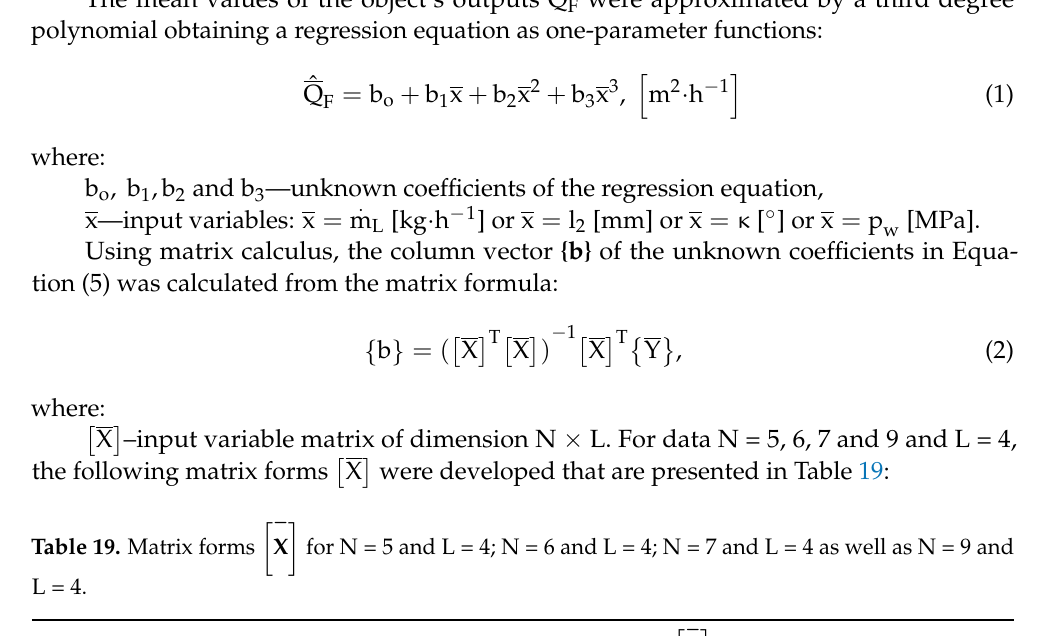
(cid:20) ¯ (cid:21) X for N = 5 and L = 4; N = 6 and L = 4; N = 7 and L = 4 as well as N = 9 and